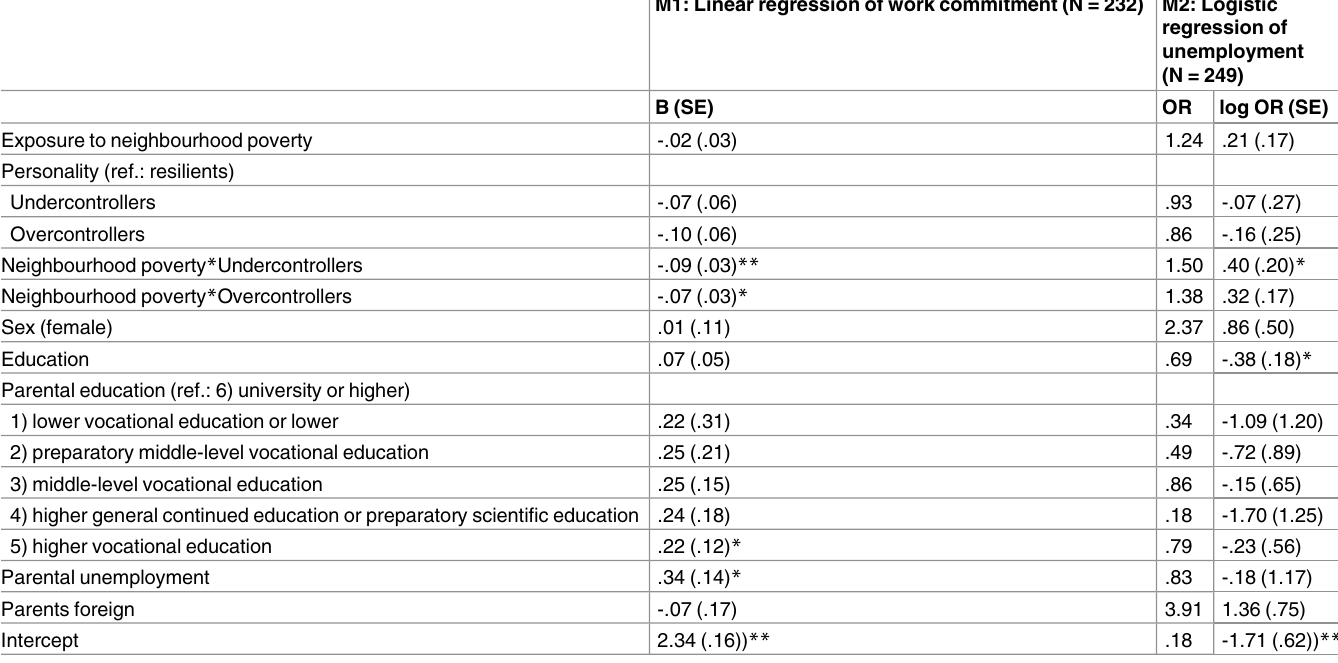
Table 3. Interaction effectsbetween adolescent personality types and exposure to neighbourhood poverty on early adulthood work commitment and unemployment.